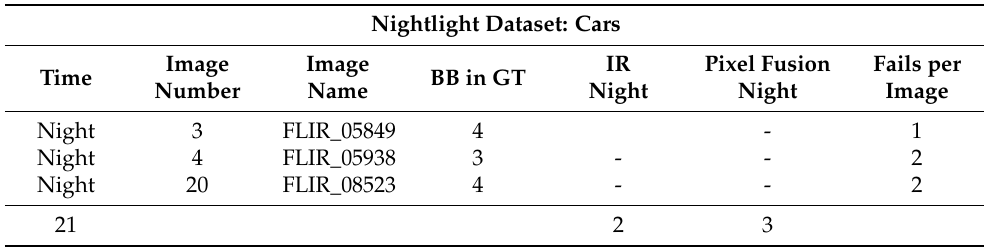
Table A4. Networks trained with nightlight image datasets failed to classify 2–3 images for car objects out of 21 night